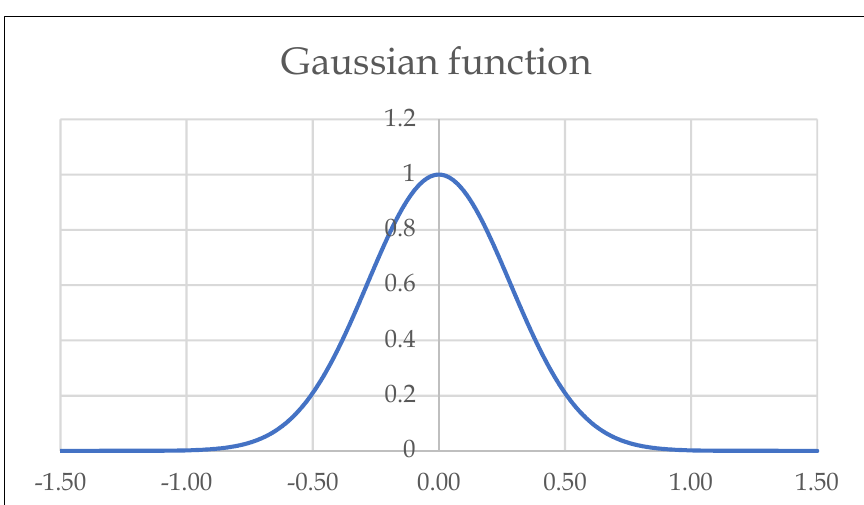
Figure 5. Gaussian function for 𝑎 = 0 and 𝑏 = 1.